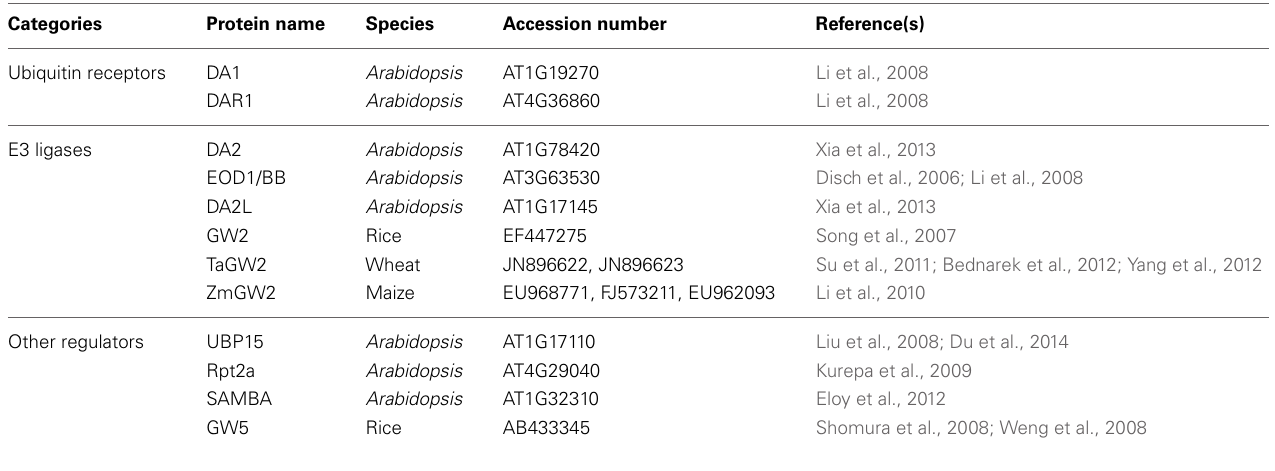
Table 1 | List of ubiquitin-related proteins involved in seed size